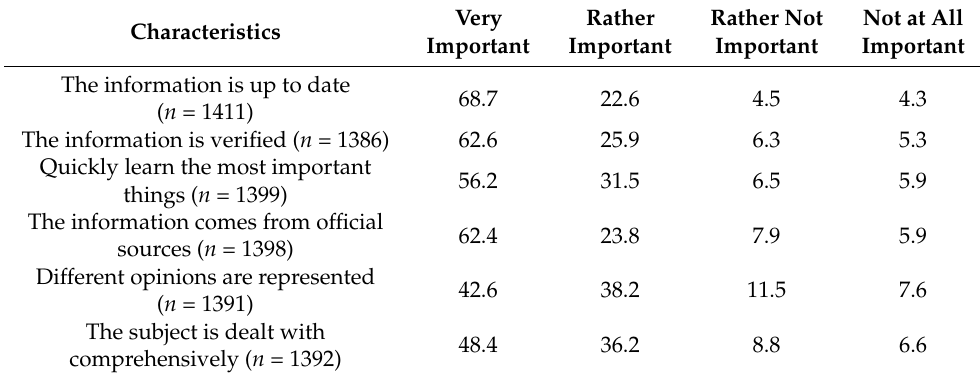
Table 6. Search for information related to COVID-19 and related topics on the